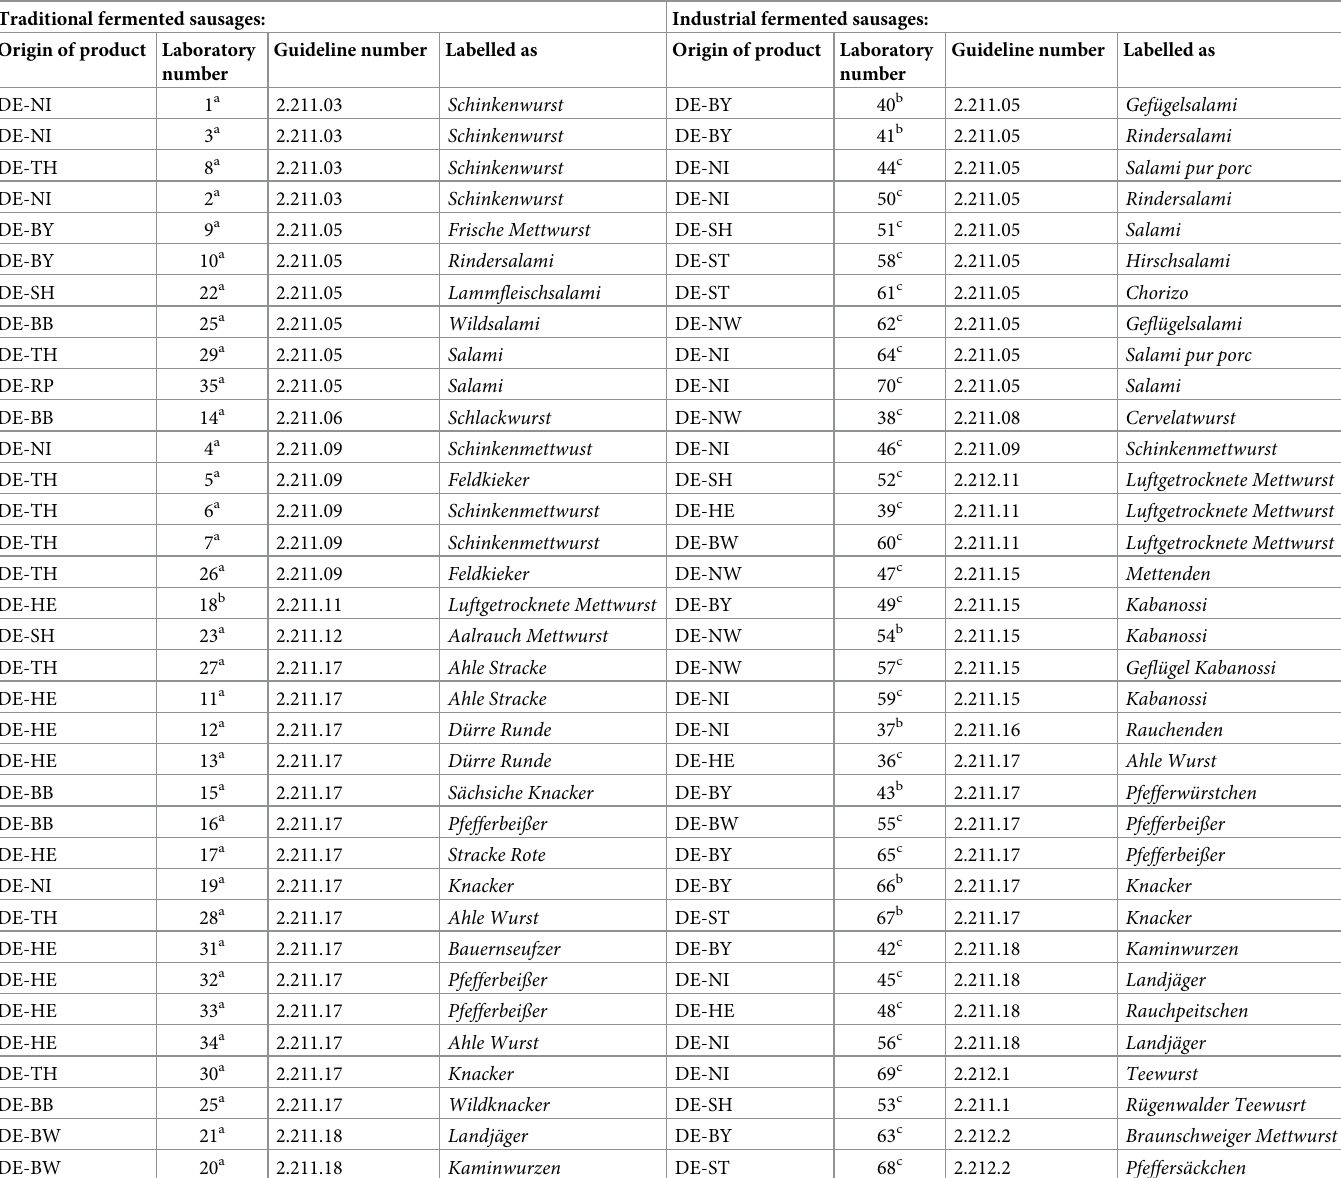
Table 1. Traditionally and industrially manufactured fermented sausages categorized in accordance with the German guidelines for meat and meat products